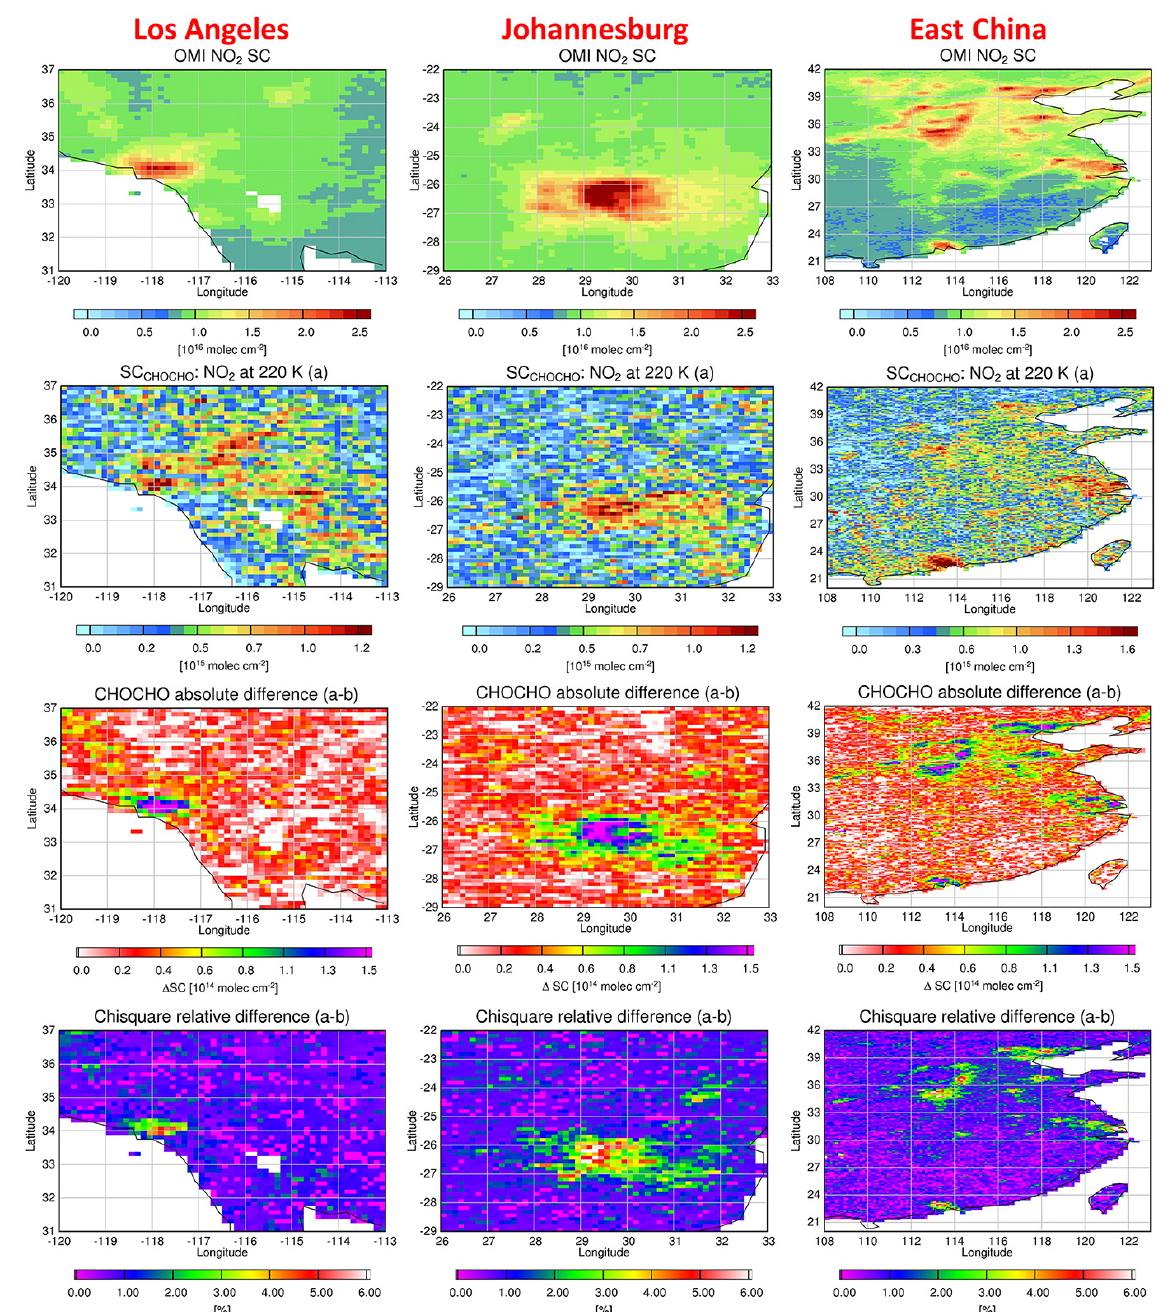
Figure 5. Monthly maps of NO 2 SCs, glyoxal SCs, glyoxal absolute differences, and chi-square relative differences between glyoxal re- trievals with and without high-temperature NO 2 absorption cross-section over Los Angeles, Johannesburg, and East China for Septem- ber 2007. (a) CHOCHO SCs retrieved with 220KNO 2 absorption cross-section. (b) An additional NO 2 absorption cross-section at high temperature (294K) is included in the glyoxal